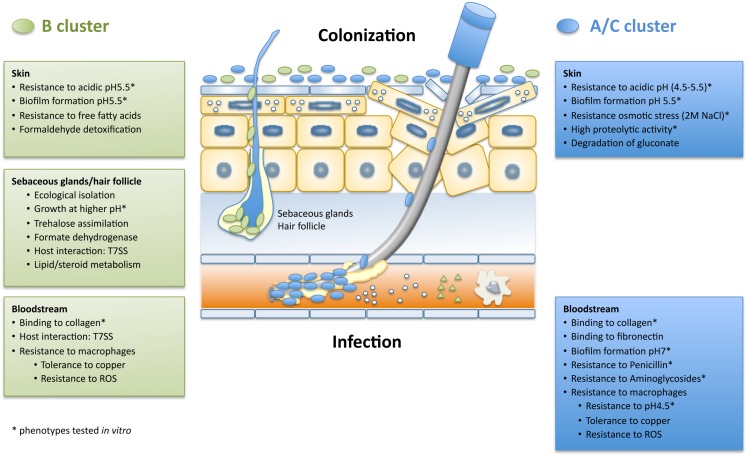
Ecological model of cluster A/C and B strains during a catheter-associated infection. This model was based on the pangenomic wide association studies and phenotypic results performed within this study. In each text box are listed the traits associated to each cluster that are important for survival and adaptation in a specific niche. A/C strains are represented by blue circles and B strains are represented by green circles.